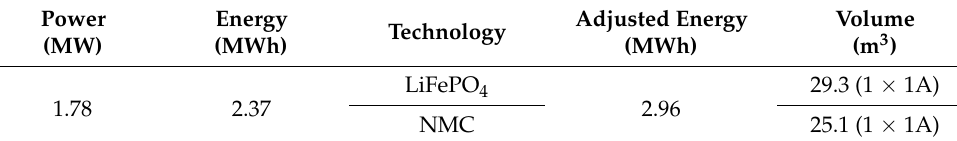
Table 12. Space requirements for the energy